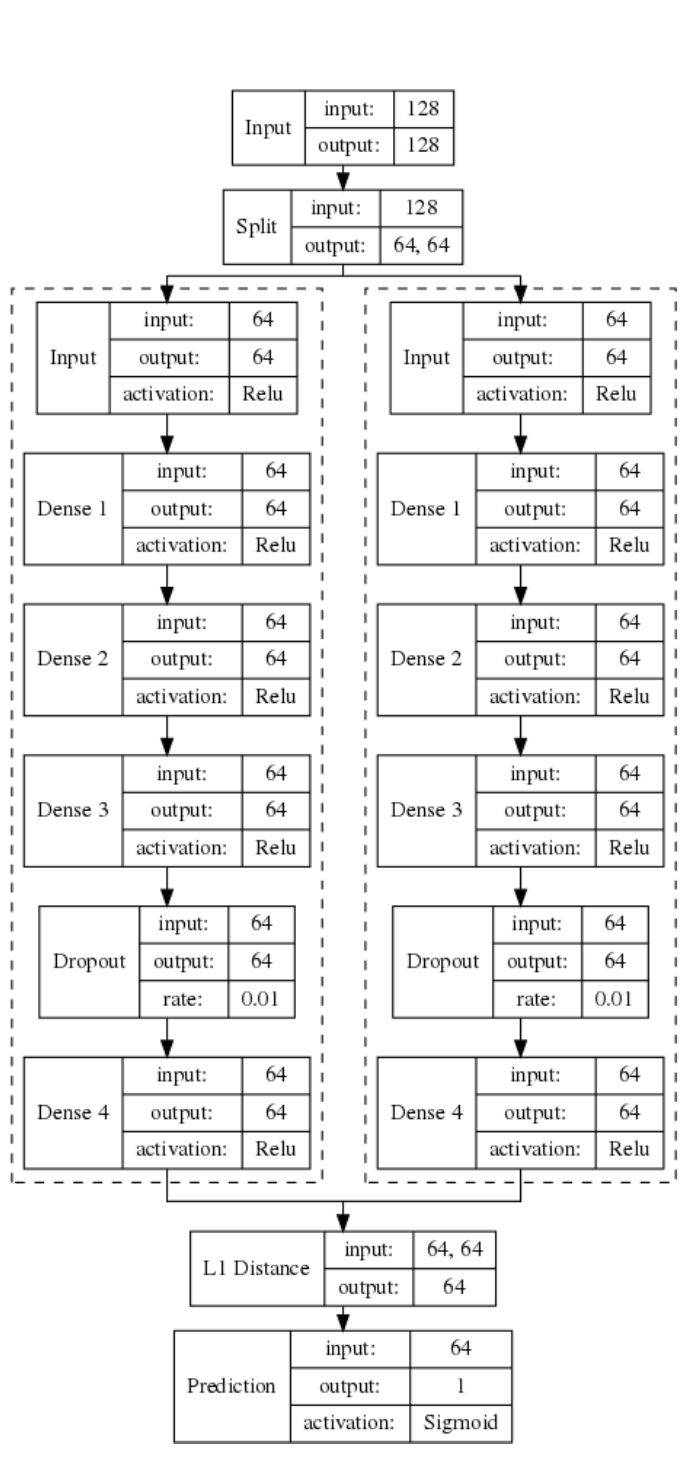
Figure 12: SNN used to learn PUF s using XOR equations derived by a repetition code. During training the loss is calculated using binary cross entropy. The chosen optimizer is Adam with default parameters and a learning rate of 0 .